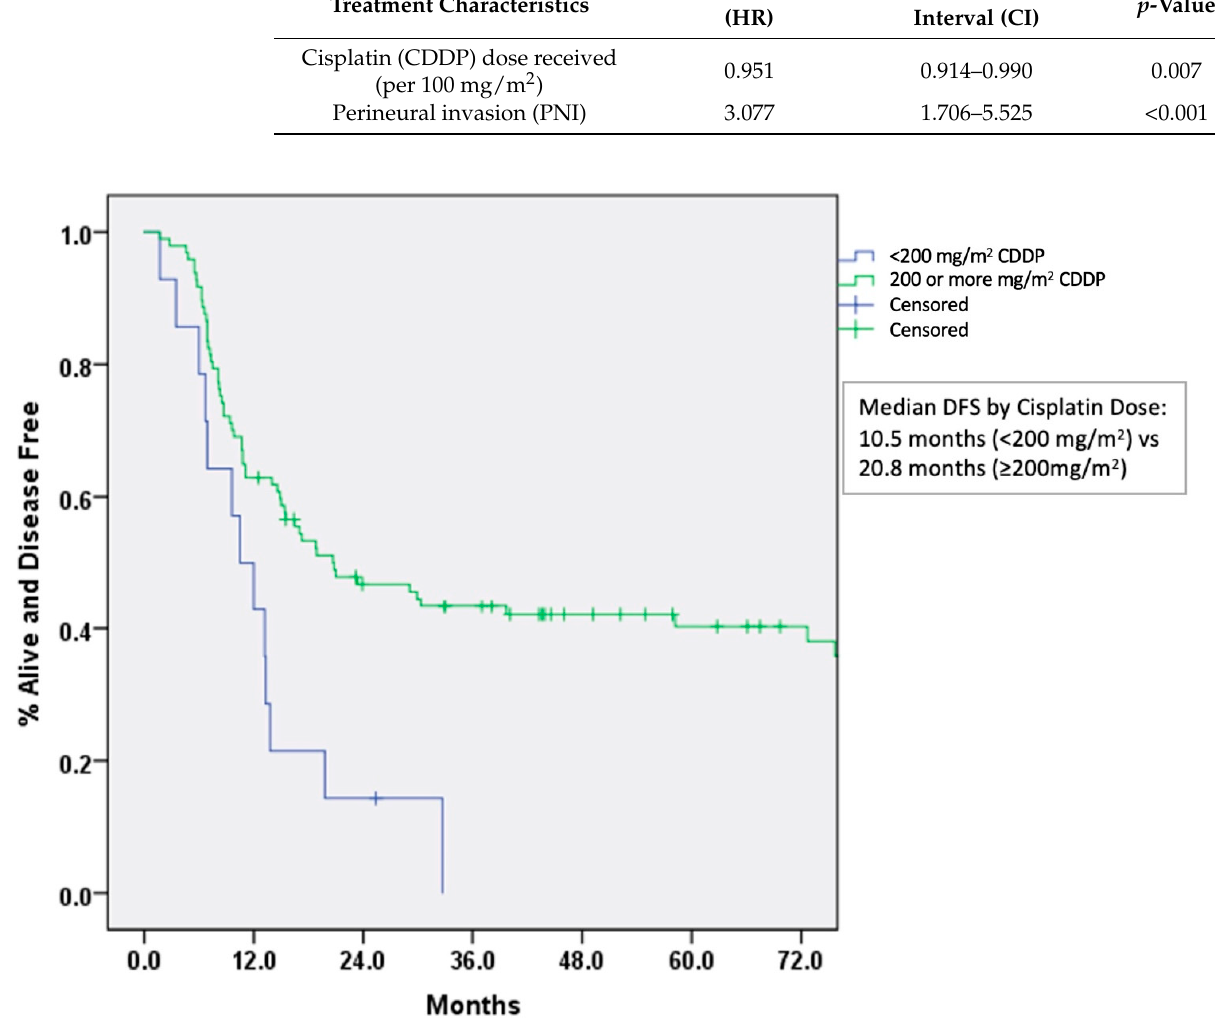
Figure 2. Disease free survival by dose of concurrent cisplatin. Abbreviations: CDDP, Cisplatin; DFS, Disease free survival.